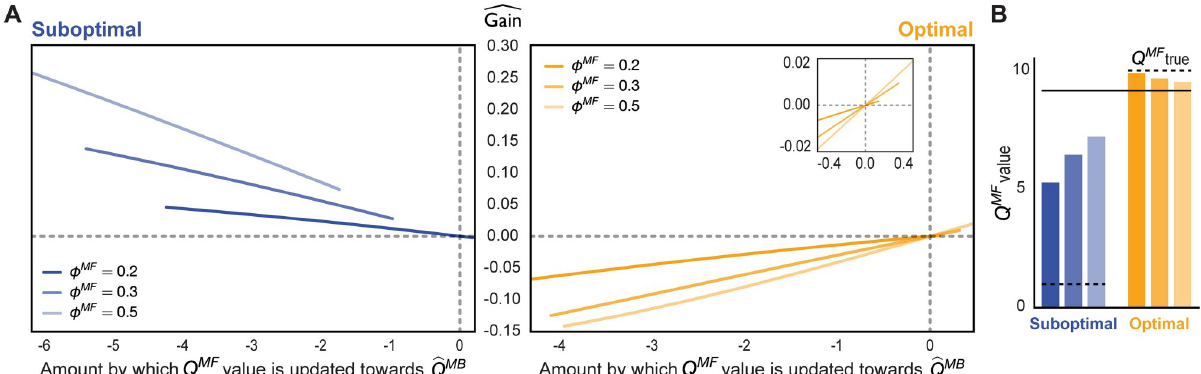
Fig 4. How MF forgetting influences gain estimation. (A) Estimated gain as a function of the difference between the agent’s current MF Q -value and the model-estimated MB Q -value, b Q MB (cid:0) Q MF , for varying degrees of MF forgetting, ϕ MF . The dashed grey lines show the x- and y-intercepts. Note that the estimated gain is negative whenever the model-generated b Q MB estimates are worse than the current MF Q -values. (B) Current MF Q -values for the optimal and sub-optimal actions with varying MF forgetting rate, coloured in the same way as above. The horizontal solid black bar is the average reward experienced so far, towards which MF values tend. The true Q -value for each action is shown in dashed black.